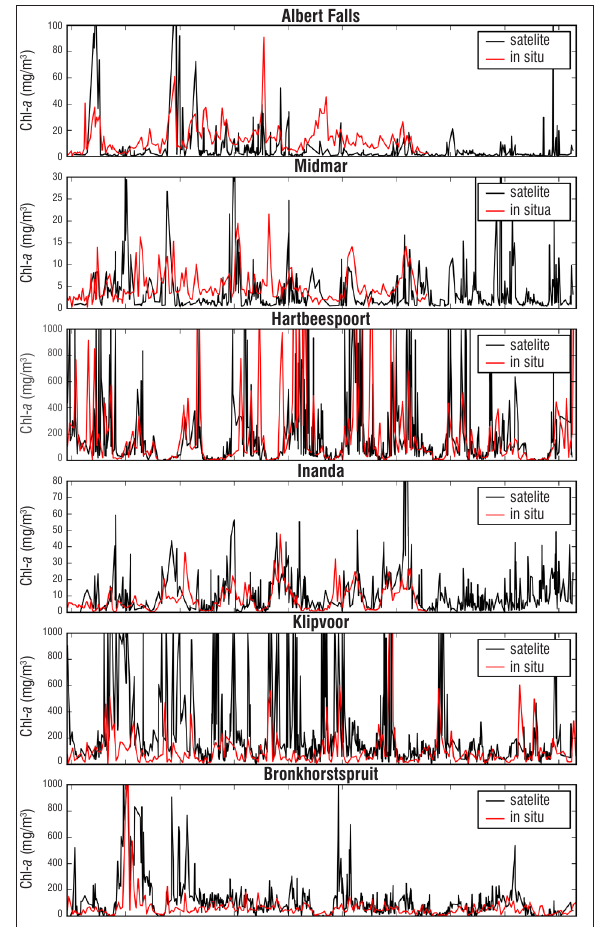
Figure 1: A comparison between the spatial distribution and magnitude of chl- a determined from in-situ and satellite measurements for Ceratium hirundinella blooms in Albert Falls Dam. The chl- a maps for (a) October 2006 and (b) January 2007 are taken from Hart and Wragg 23 with permission. MERIS scenes acquired simultaneous to in-situ measurements are shown for (c) 13 October 2006 and (d) 22 January 2007.